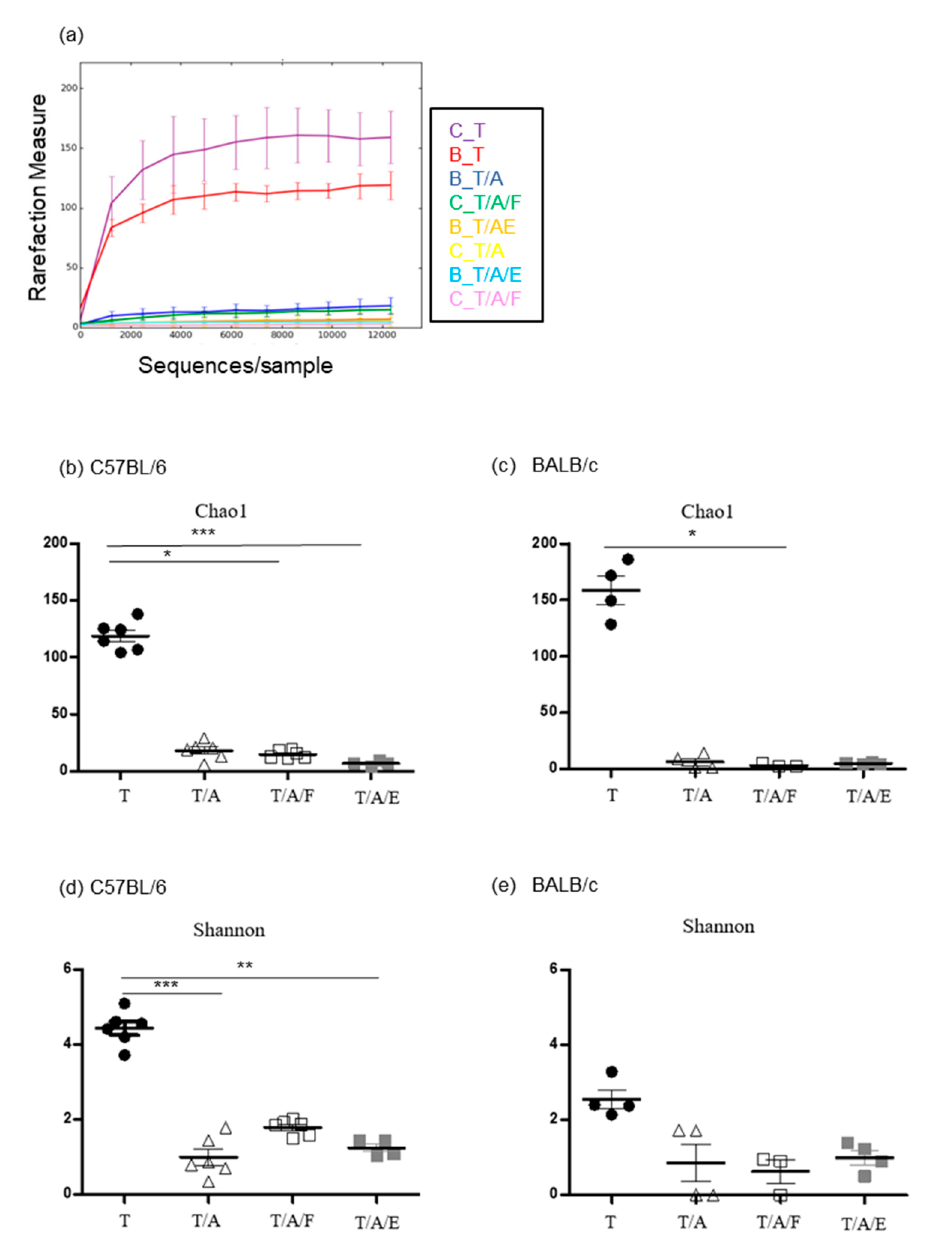
Figure 3. Oral gavage of bacteria does not increase microbiome alpha diversity in antibiotic-treated mice. The microbiome was analysed by 16S rDNA V3V4 sequencing using caecal content obtained from mice on the 8th day after tumour challenge. ( a ) Rarefaction curves after adjusting the read number of each sample by subsampling. ( b – e ) Alpha diversity determined by the Chao1 or Shannon method. Each symbol represents each sample. C_T and B_T: BALB / c and B6 mice treated with Tim3VdIg alone, respectively; C_T / A and B_T / A: BALB / c and B6 mice treated with Tim3VdIg and antibiotics; C_T / A / F and B_T / A / F: BALB / c and B6 mice treated with Tim3VdIg, antibiotics, and faecal bacteria; C_T / A / E and B__T / A / E: BALB / c and B6 mice treated with Tim3VdIg, antibiotics, and Enterococcus hirae . Data represent mean ± standard deviation. * p < 0.05, ** p < 0.01, *** p < 0.001.